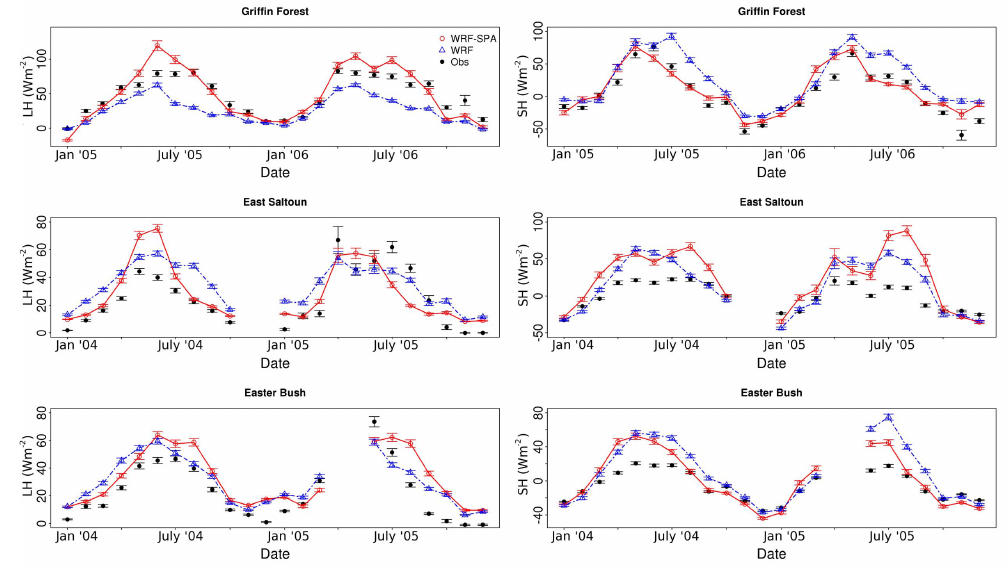
Fig. 3. Monthly mean values for LH and SH fluxes by observations, WRF-SPA and WRF. Error bars are ± 1 standard error, accounting for temporal averaging only.